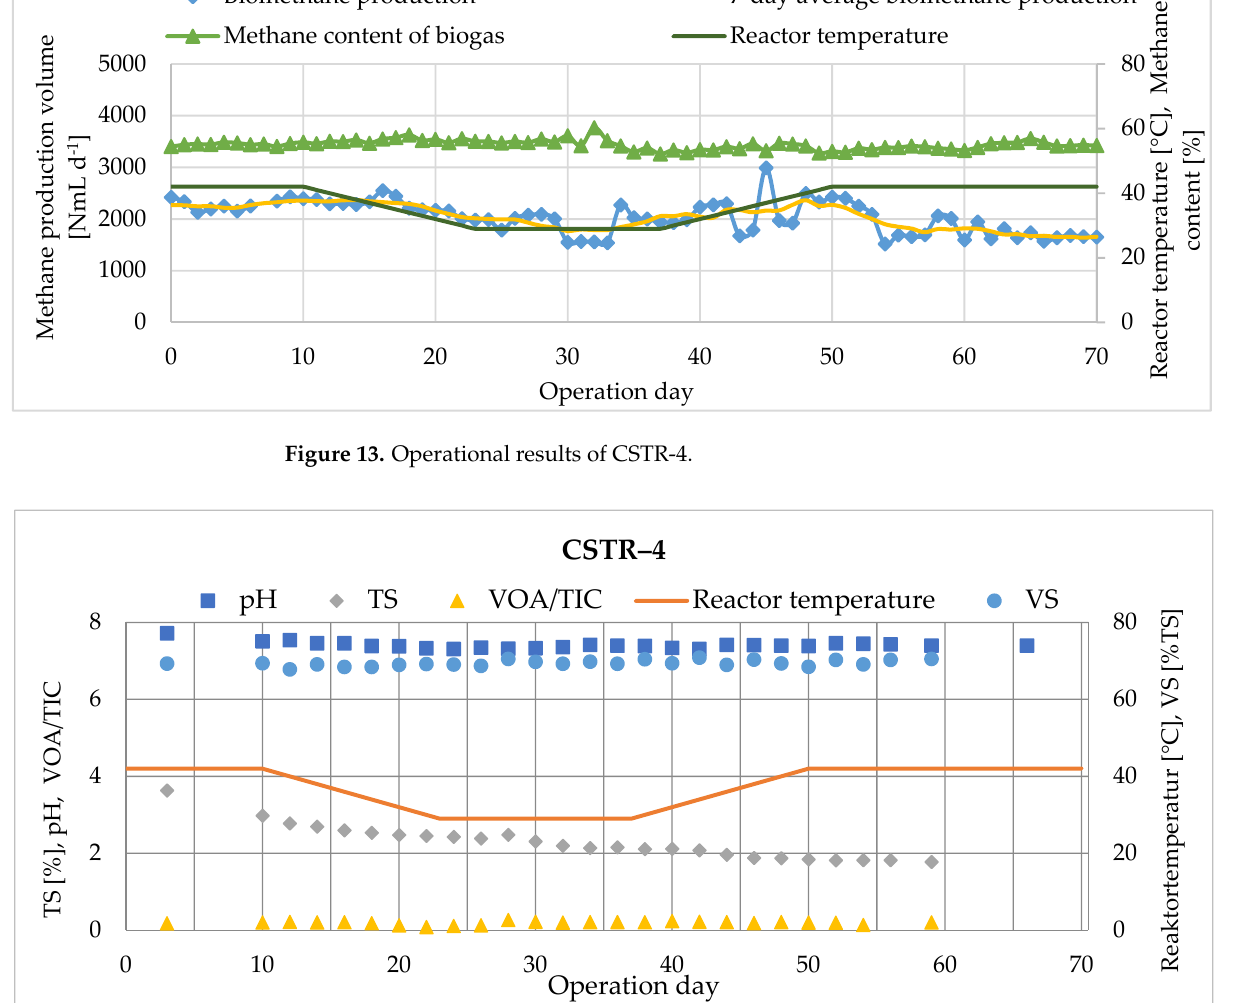
Figure 13. Operational results of CSTR-4.